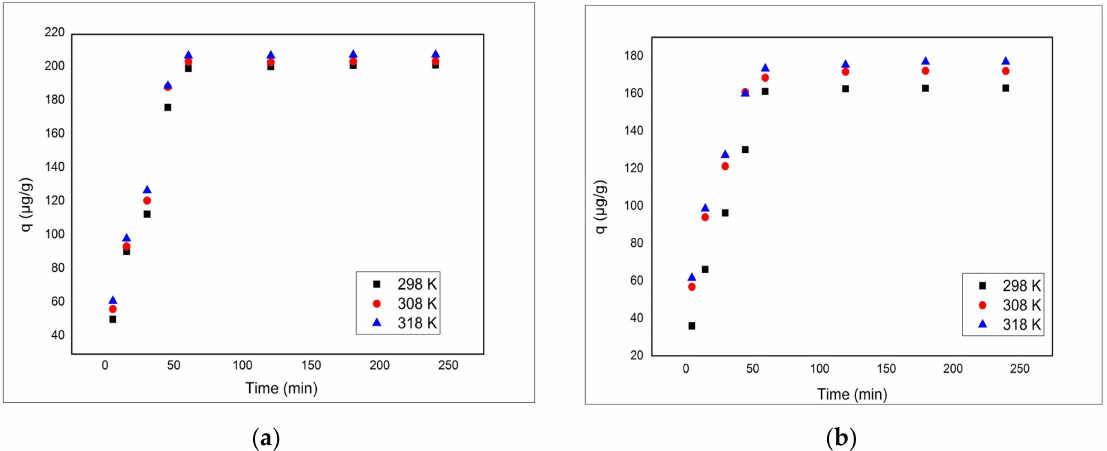
Figure 6. Effect of contact time and temperature on adsorption capacity of materials: ( a ) V-DEHPA-Fe and ( b ) VF-DEHPA-Fe (m = 0.1 g, v = 25 mL, C 0 = 1 mg L − 1 As(V), pH =